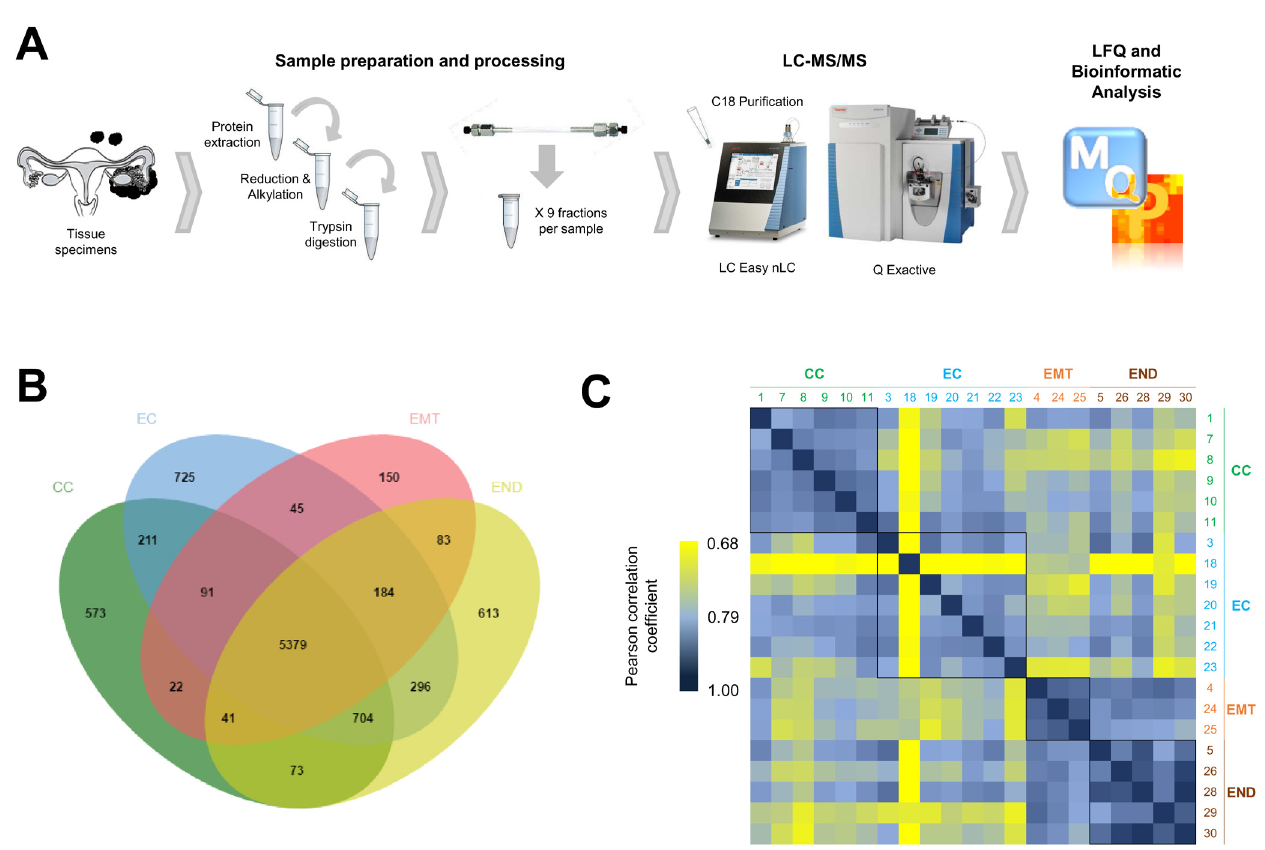
Figure 1. Proteomic workflow and dataset. ( A ) Overview of the label-free LC-MS/MS workflow developed for proteomic analysis of tissue specimens. ( B ) Venn diagram displaying overlap of proteins between the four patient cohorts. ( C ) Interpatient correlation of the protein expression